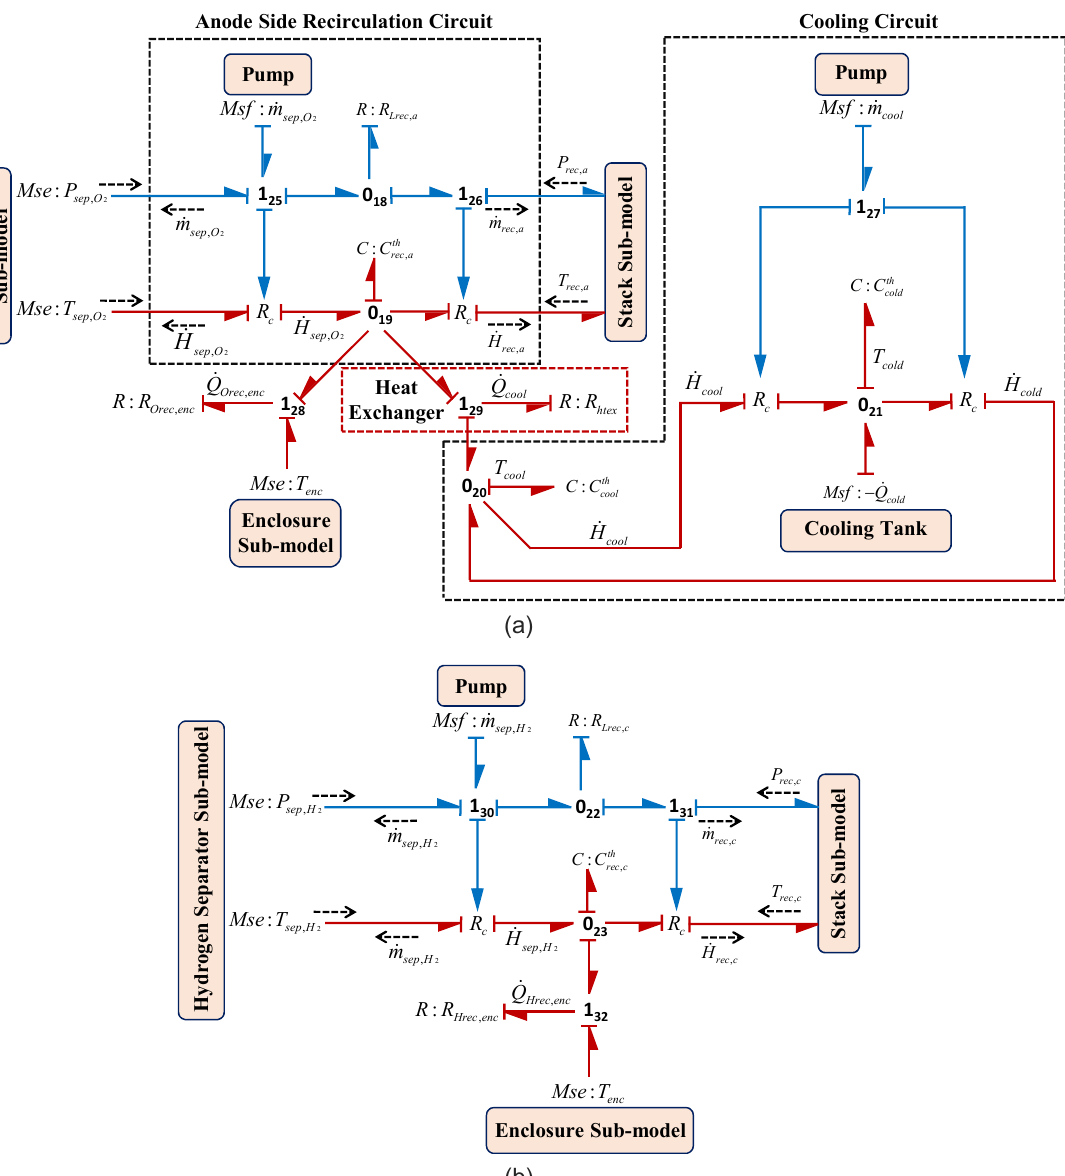
Figure 16. BG recirculation sub-models ( a ) anode side including cooling circuit and ( b ) cathode